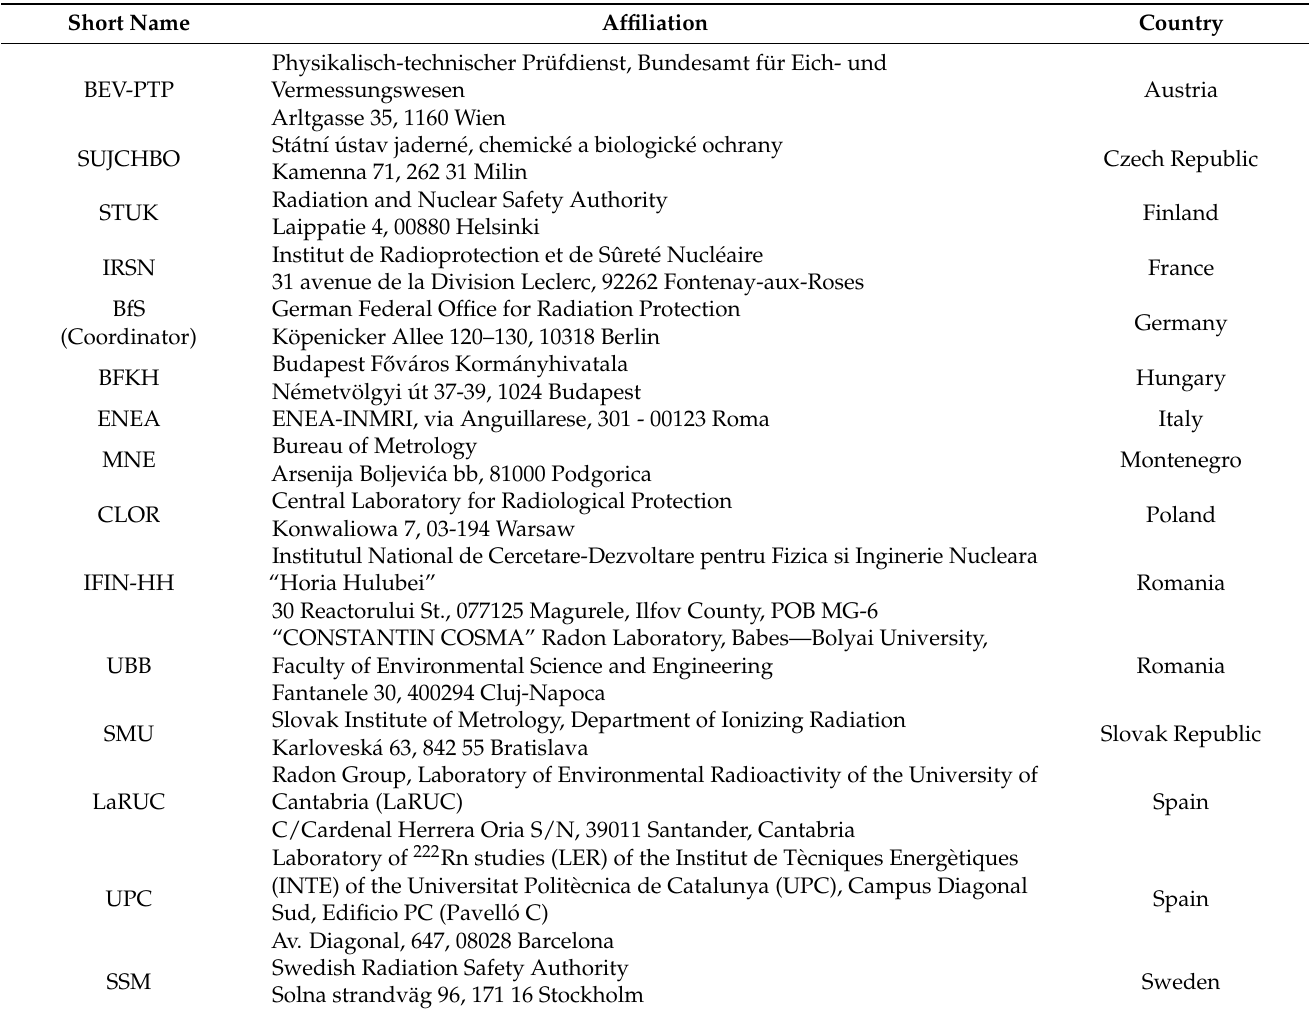
Table 1. Calibration facilities participating in the interlaboratory comparison (sorted alphabetically by